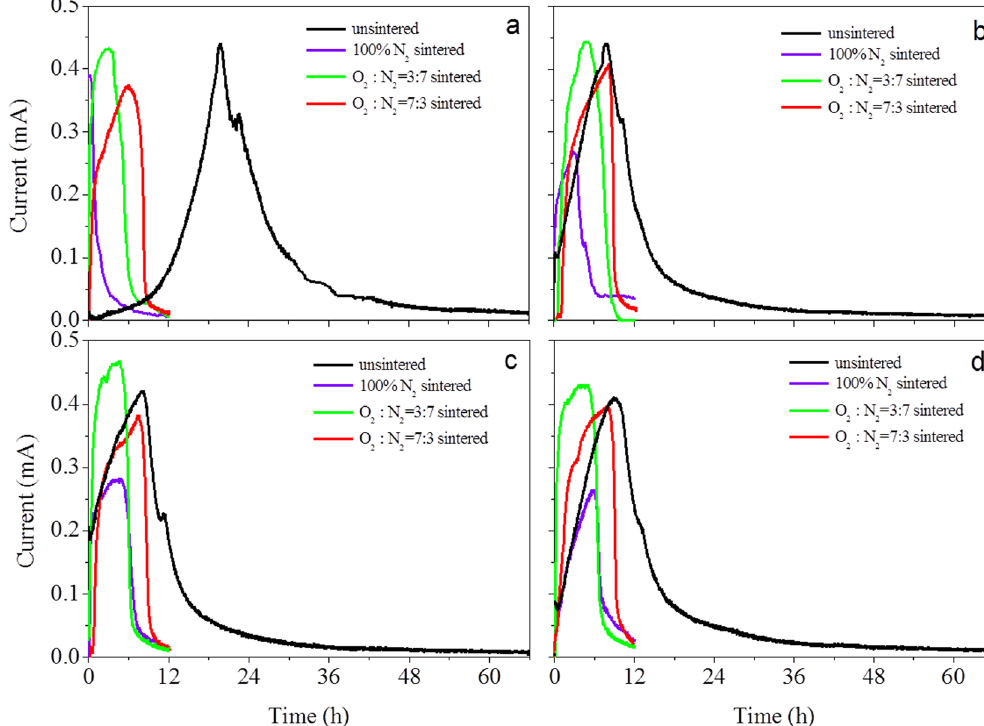
Figure 4. Charging curves of CB electrodes in MFCs ( a : the newly fabricated electrodes with different pre- treatments, b : charged electrodes in ‘a’ discharged with 0.1 mA constant current, c : charged electrodes in ‘a’ discharged with 0.5 mA constant current, d : charged electrodes in ‘a’ discharged with 1.0 mA constant current).